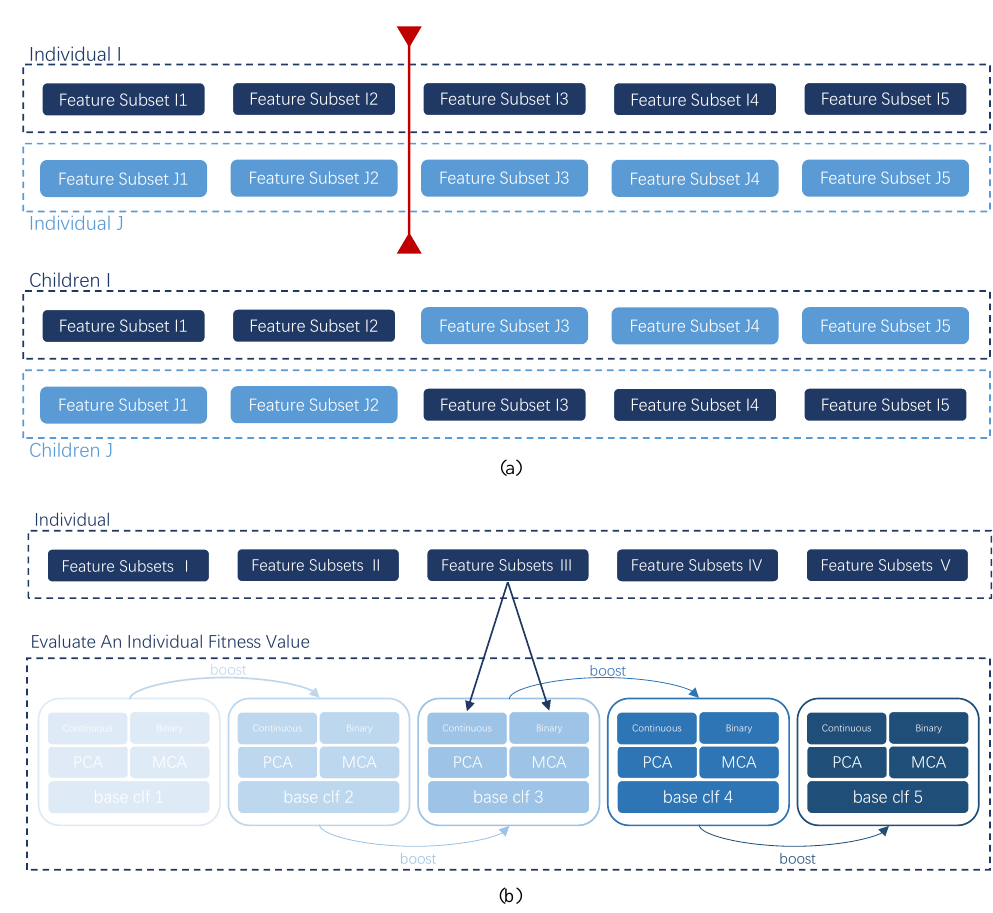
Figure 3. Genetic Operator: ( a ). Schematic diagram of the cross operation. Two individuals generate offspring by exchanging the parts before and after the Crossover Point. ( b ). Specific calculation flow chart of the fitness function.